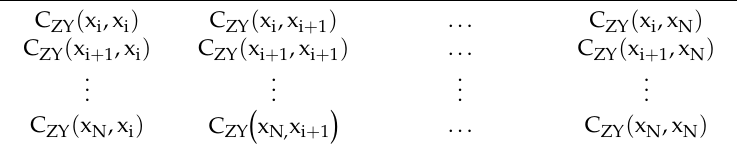
Table 2. Structure of the cross-covariance